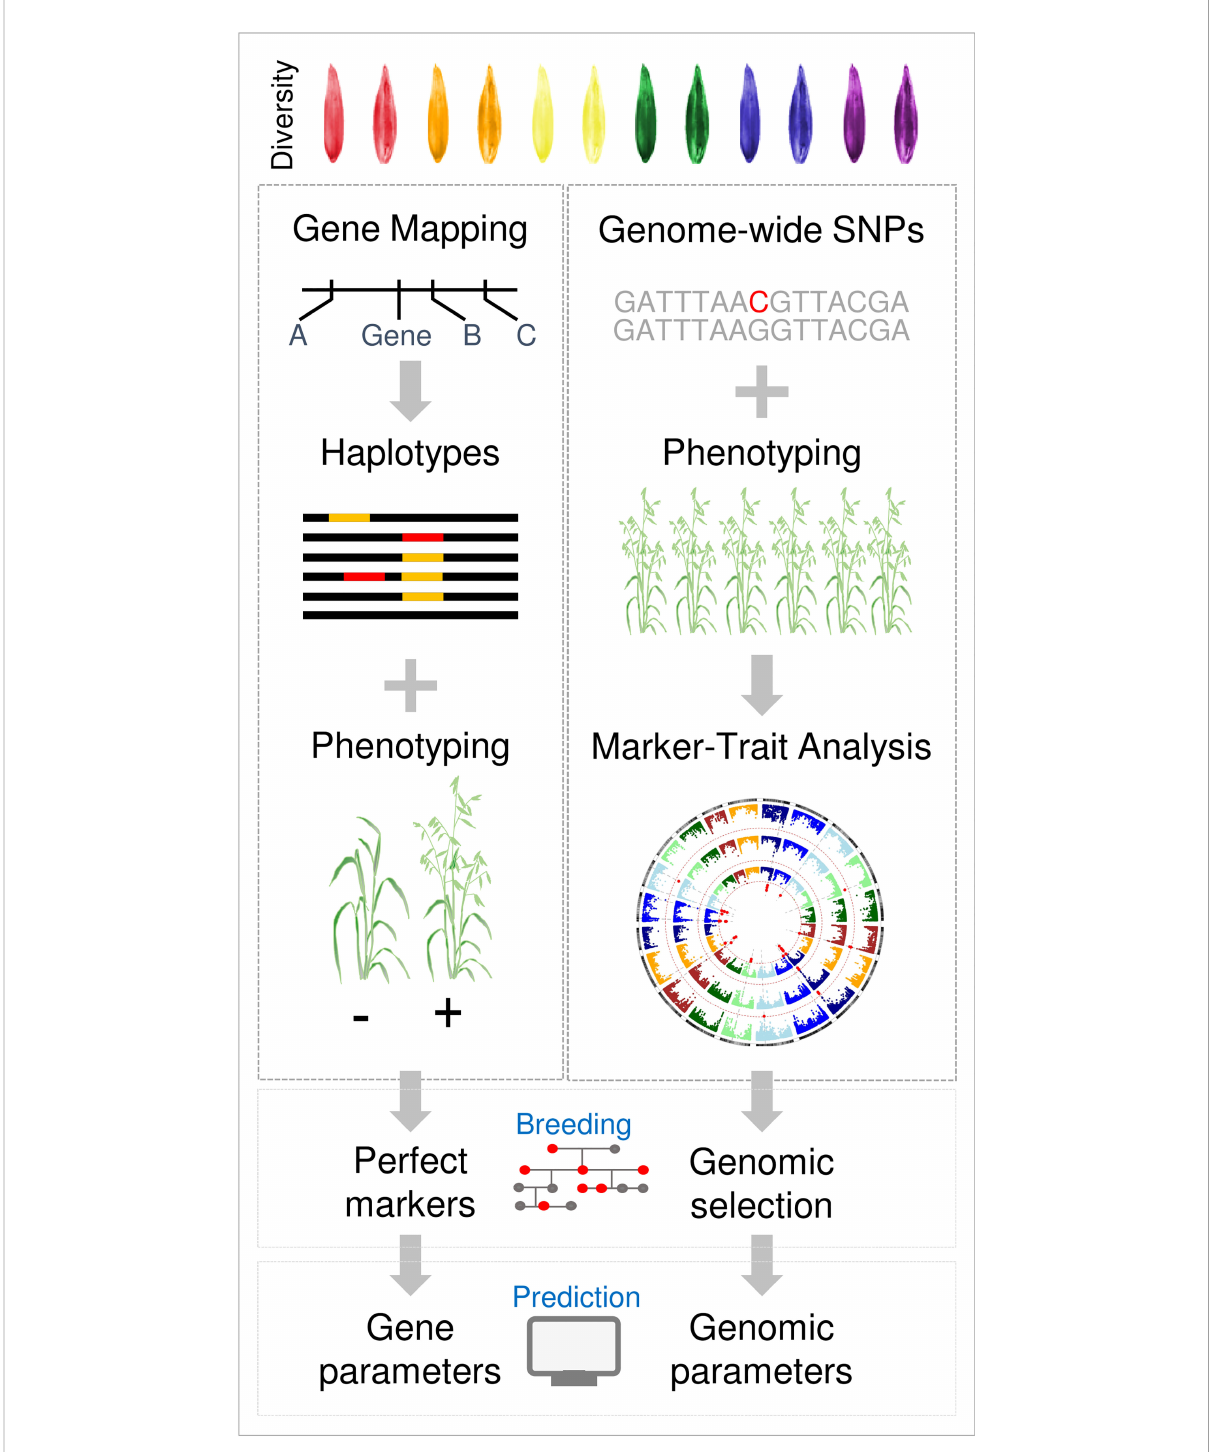
FIGURE 4 Overview of future oat phenology research strategies. A traditional strategy, based on approaches applied to wheat and barley, is compared with a “ genome-to-phenome ” strategy. In the traditional approach individual phenology traits are mapped to genes, using bi-parental mapping populations, for example. Knowledge of variation in these genes is then assembled by gene resequencing and used to design molecular markers for genotyping. In parallel, bespoke genetic resources such as near-isogenic lines or induced mutants are used to test gene function. In the genome-to-phenome strategy diversity panels are used to link genome-wide genetic diversity to broad phenotypic variation (phenology in this case). Marker-trait associations are then used for genomic prediction or to inform crop simulation models that predict